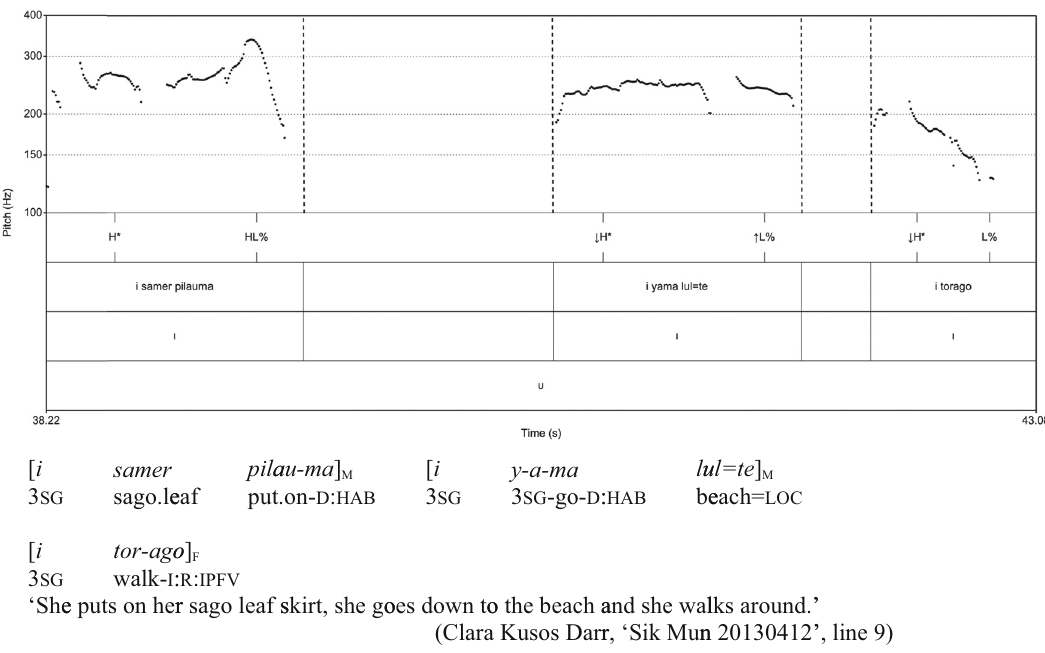
Figure 5: Clause chain with HL% on the fi rst medial clause.